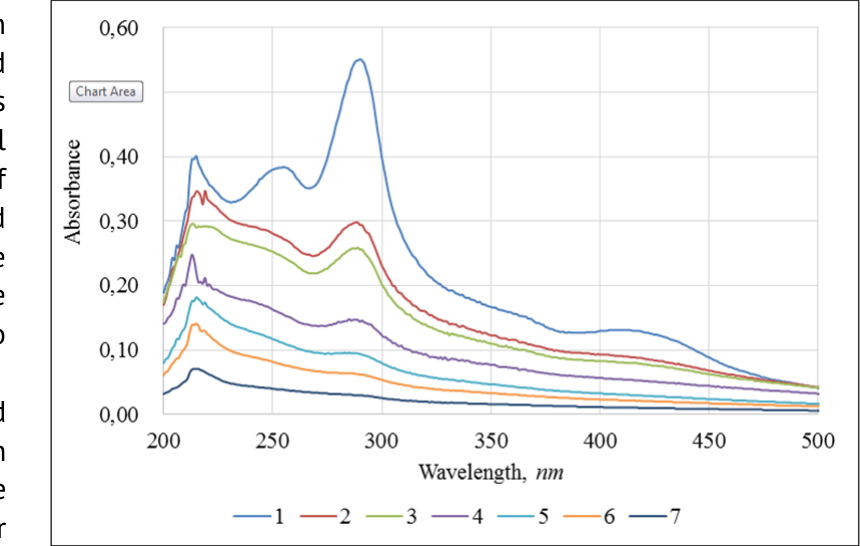
Figure 4. UV-Vis spectra of consecutive